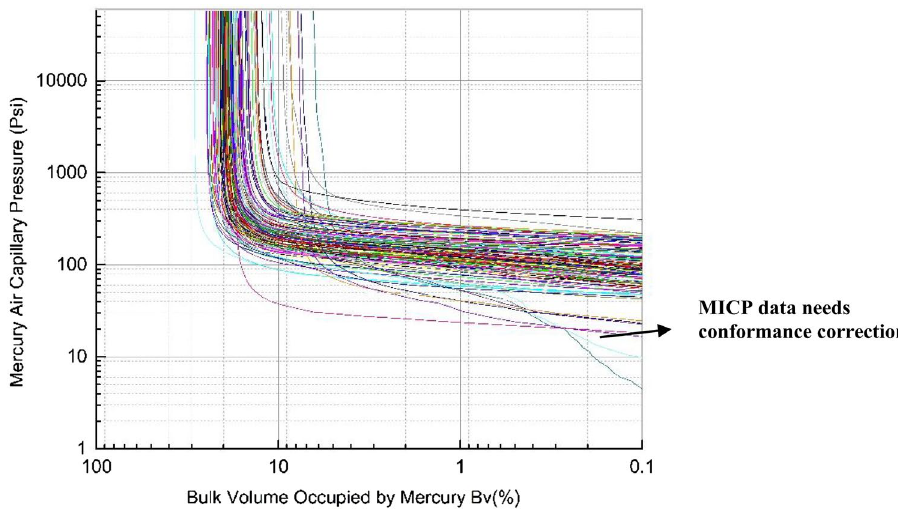
Fig. 2 MICP dataset from core plugs in transition zone from a tight carbonate